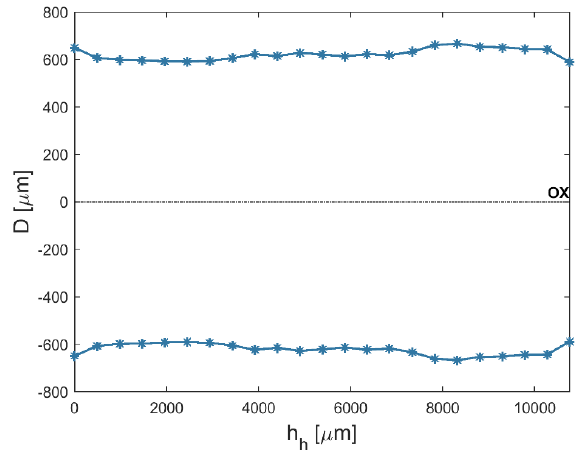
Figure 10. The profile of the drilled hole for the maximum value of applied pulse time t i = 999 µ s, U = 100 V, I = 3.83 A, tap α = 0.006.